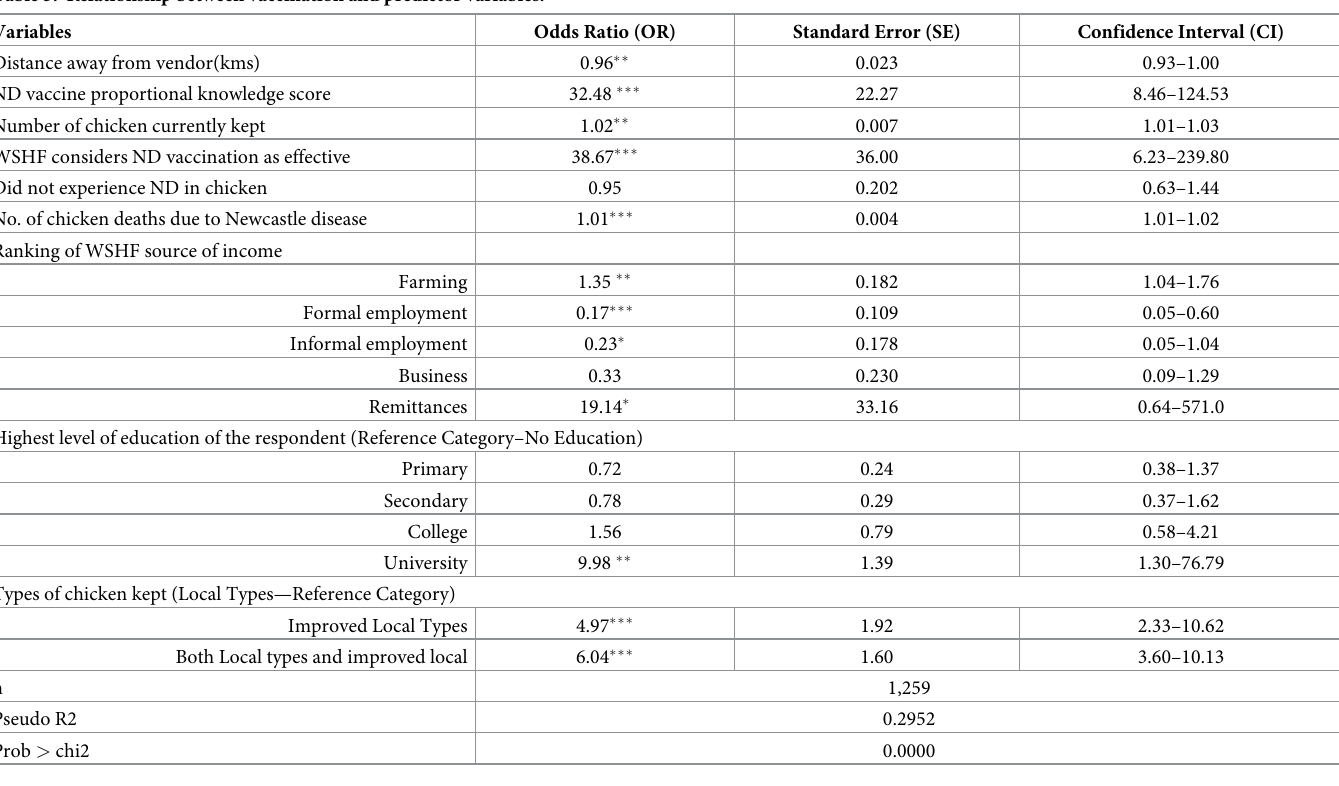
Table 3. Relationship between vaccination and predictor